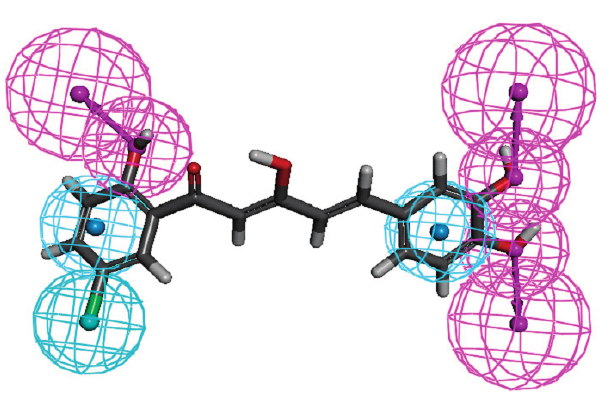
Figure 7. Pharmacophore mapping of compound 88 . Features are color-coded as follows: hydrophobic aromatic (HA), blue; hydrophobic (HYP), cyan; hydrogen-bond donor (HBD),